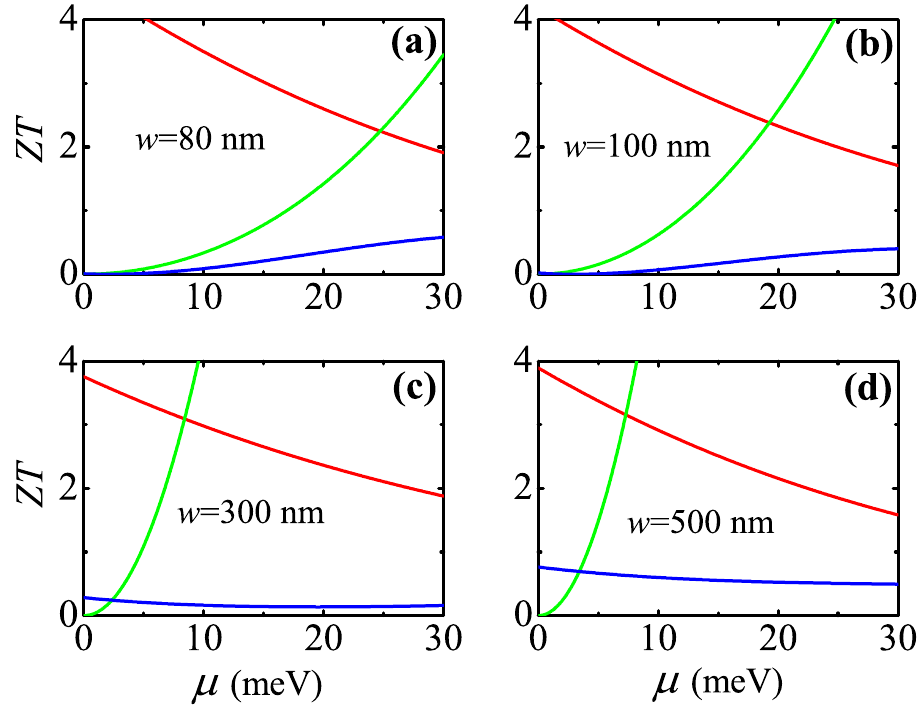
Figure 8. High-temperature ZT as a function of the chemical potential for various 2D TIs with different ribbon widths: ( a ) w = 80 nm, ( b ) w = 100 nm, ( c ) w = 300 nm, and ( d ) w = 500. Here, the black solid (dashed) line represents the edge (bulk) band-edge, the red and green solid lines represent the edge-state and bulk-state contributions to the TE transport, respectively, and the blue solid line represents the total TE transport. The temperature and QW thickness are fixed at T = 250 K and d = 13